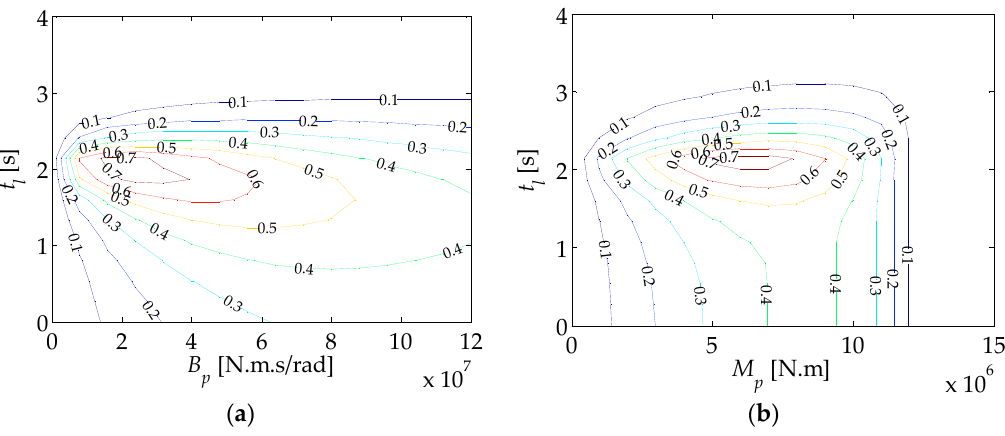
Figure 6. Relative capture width as a function of the PTO moment setup and latching duration at T = 10 s: ( a ) for the linear load; ( b ) for the coulomb load.